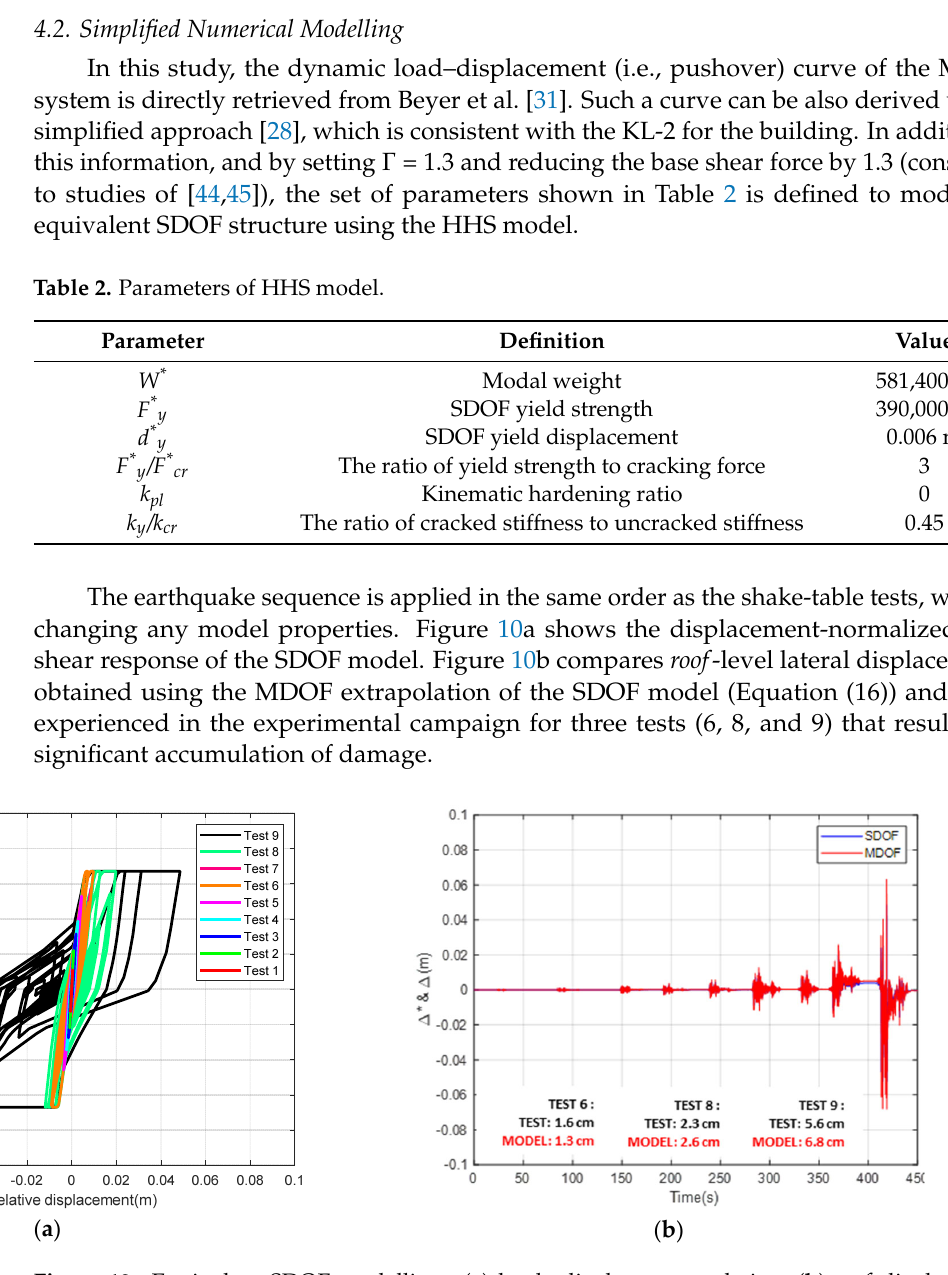
Figure 9. Comparisons of roof level acceleration response histories between the complete numerical model and observed data for ( a ) Test 1 and ( b ) Test 7.